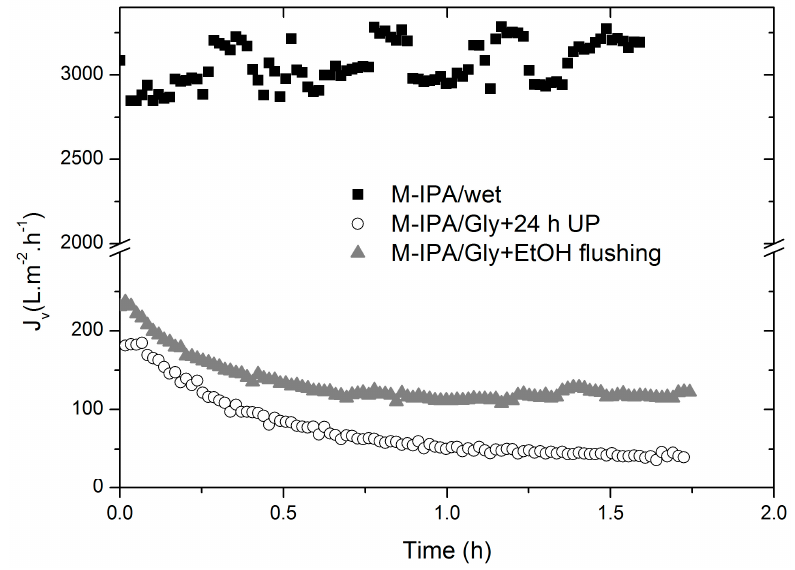
Figure 3. Representative curves of the change with time of the overall water flux of M-IPA/Gly and M-IPA/wet membranes during CWF filtration experiments under TFF mode at a constant working pressure of 0.16 bar and 37 °C.